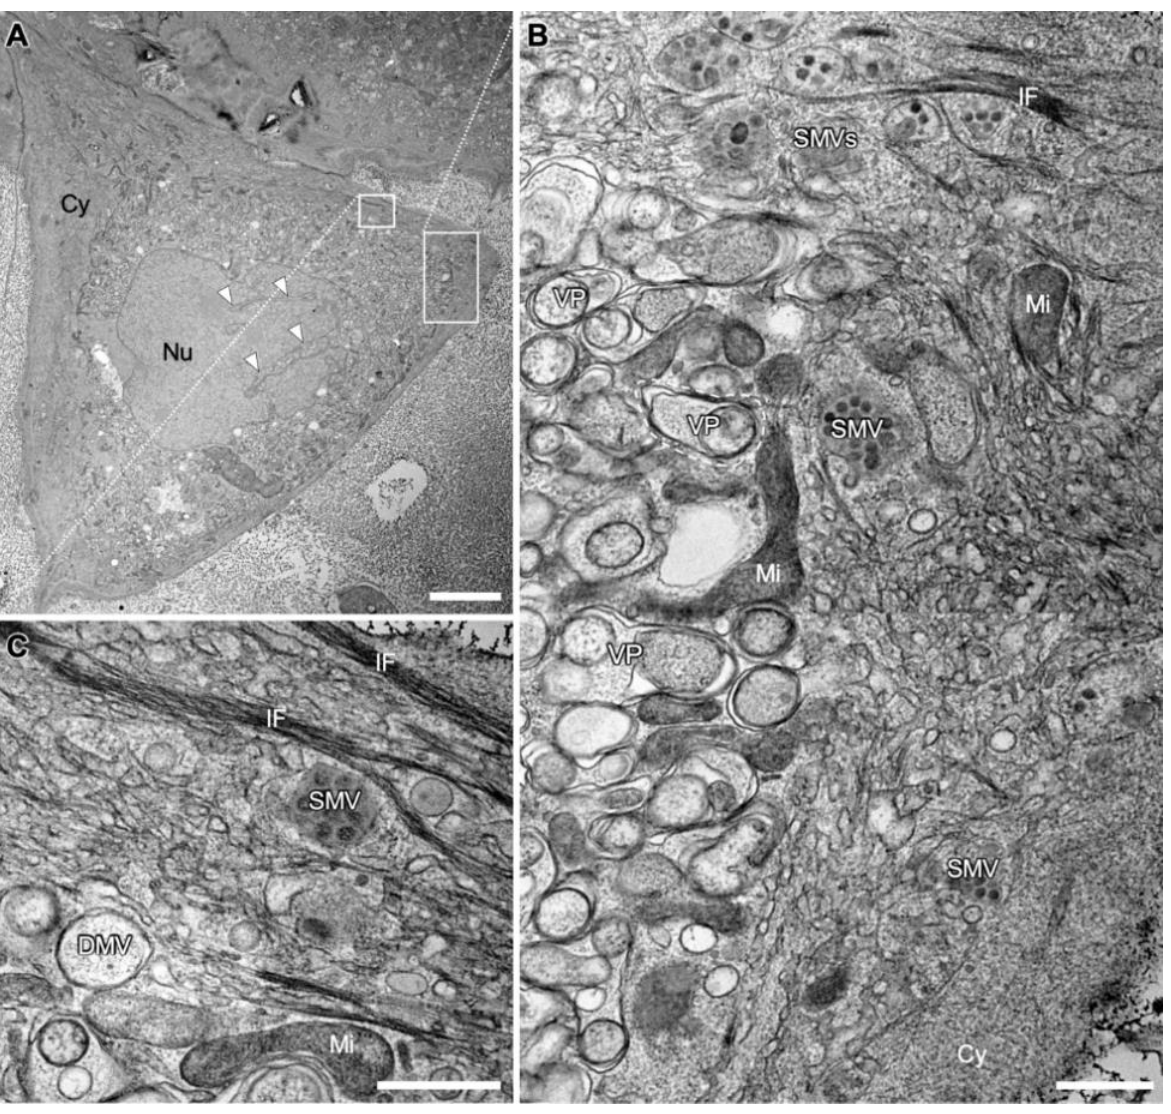
Figure 1. Transmission electron microscopy (TEM) images of a SARS-CoV-2 infected Vero E6 cell at 24 hpi. ( A ) Overview image showing cytopathic alterations, such as the compartmentation of the cytoplasm (Cy). Invagination of the cytoplasm into the nucleus (Nu) is marked with white arrowheads. ( B ) Larger magnification of the indicated area marked in A, illustrating the compartmentation into a perinuclear area on the left and a peripheral area on the right. The perinuclear area is occupied almost exclusively by densely packed double membrane vesicles (DMVs) and numerous vesicle packets (VPs), arising from multiple DMVs fusing at their outer membrane [19,24]. The pe- ripheral area is occupied by cell organelles such as mitochondria (Mi) and endoplasmic reticulum (ER) and single membrane vesicles (SMVs) filled with virions. ( C ) Larger magnification of the area indicated in A with bundles of intermediate filaments (IF), SMV, DMV and a mitochondrion (Mi). Scale bars: ( A ) 10 µm; ( B ) and ( C ) 500 nm.